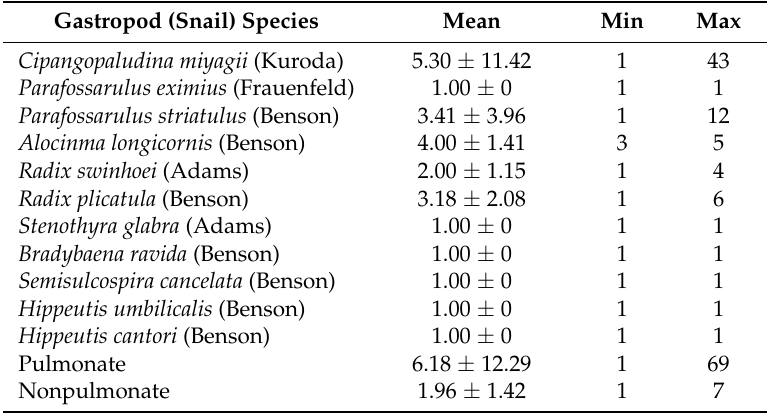
Table 2. Mean abundance ± SD of the gastropods collected from 32 lakes.